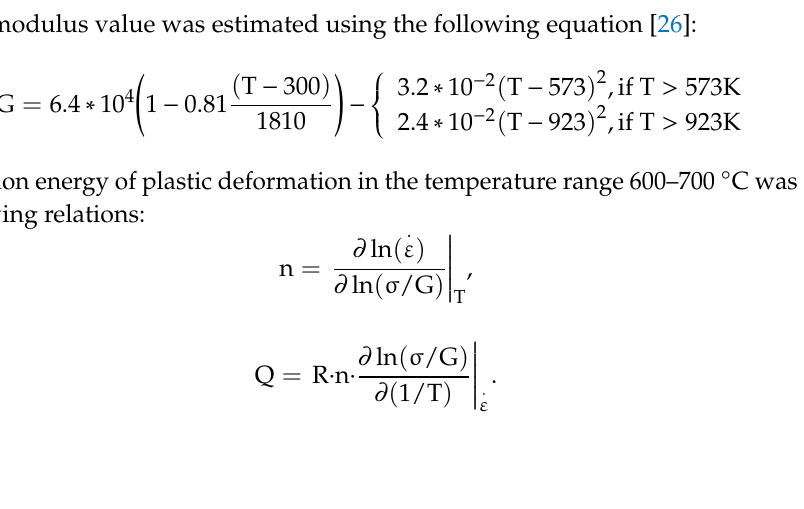
Figure 2. Relationship between true stress ( ε ~ 0.25) and compression temperature.